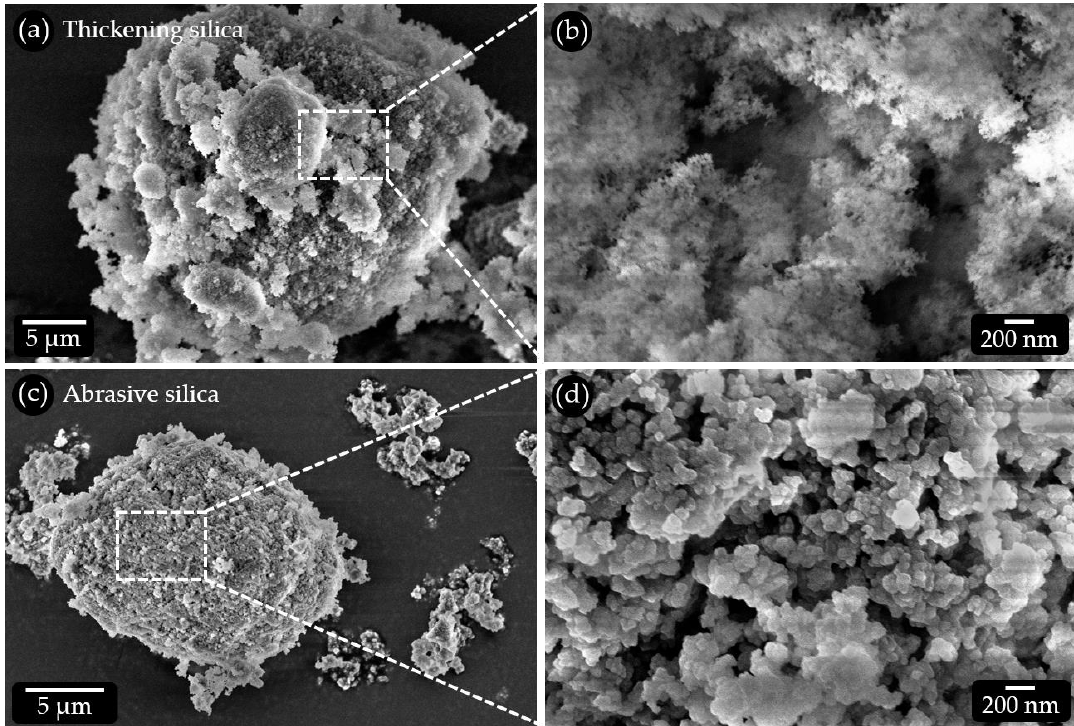
Figure 3. SEM micrographs of the hydrated silica particle types used for the model toothpastes. ( a ) Thickening hydrated silica particles show a very finely structured surface. They consist of ( b ) nanoscopic coherent particles creating a high porosity. ( c ) Abrasive hydrated silica particles are more compact and consist of ( d ) about 200 nm large, roughly polyhedral particles with sharp edges that form clusters.